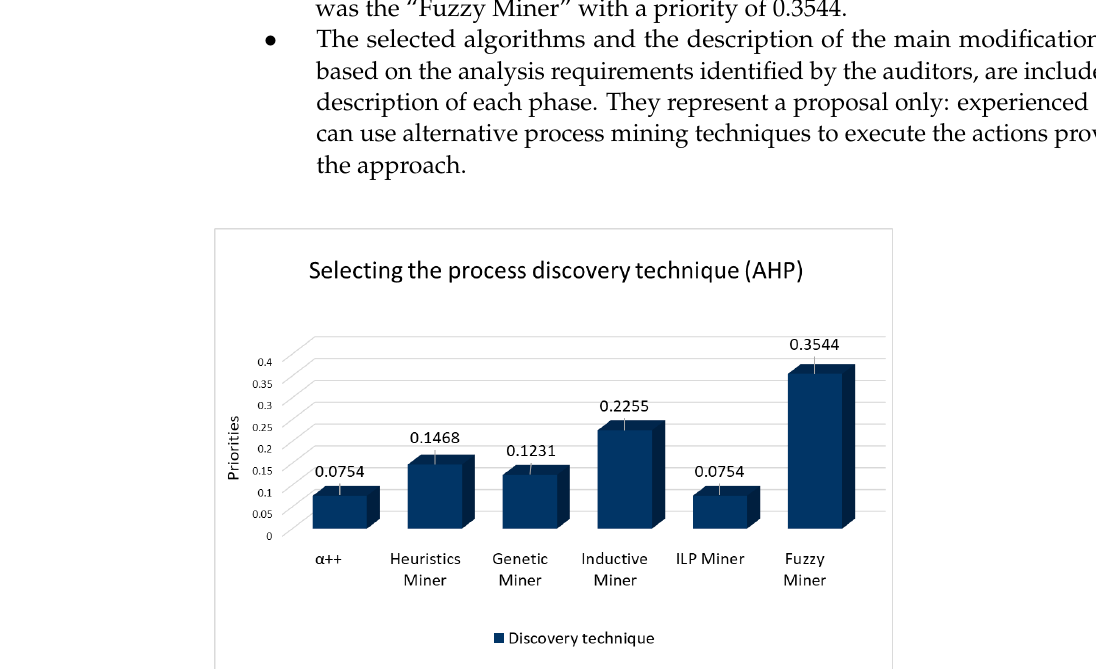
10 of 31 Table 2. Summary results of the Delphi method to determine and weigh the selection criteria. Criteria